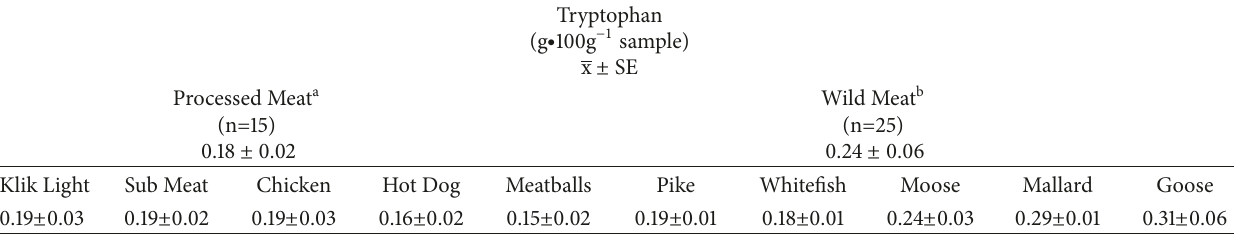
Table 4: Total Tryptophan Content In Original Wet Samples Of Processed And Wild Meats.